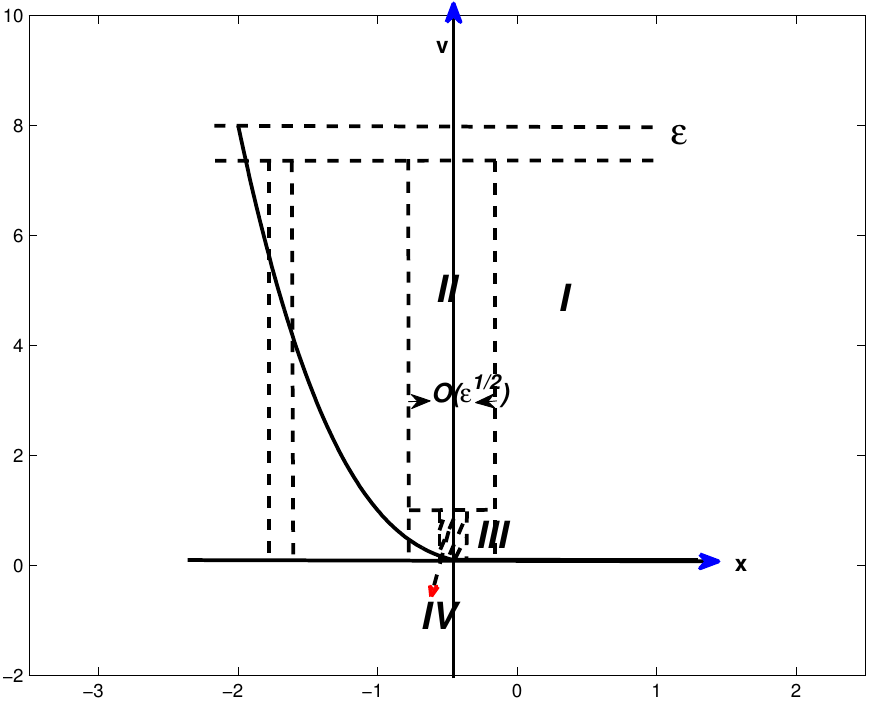
Figure 1. Boundary layer